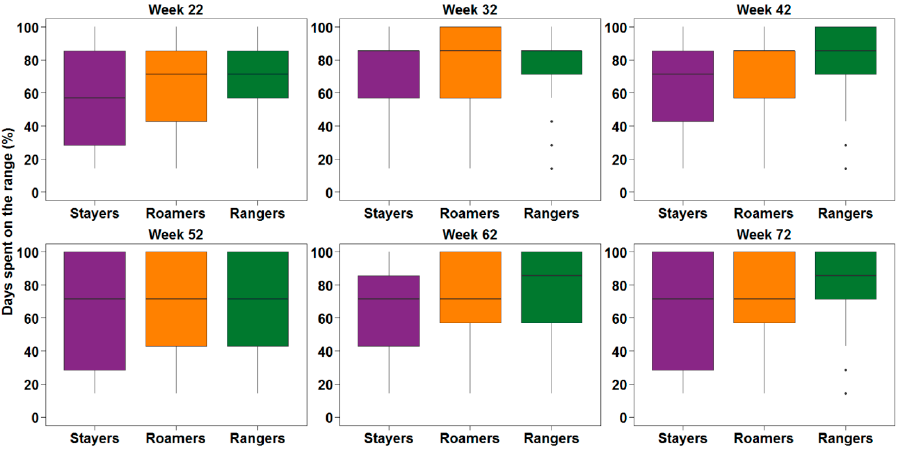
Figure 5. Boxplots showing the percentage days on the range of the sub-population of stayers (purple), roamers (orange), and rangers (green) when hens were 22, 32, 42, 52, 62 and 72 weeks of age. The data shown here are pooled from 5 flocks which served as replicates for statistical analysis.